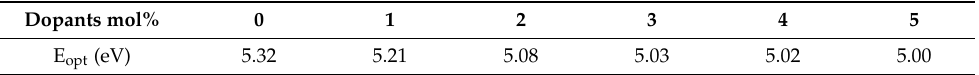
Table 5. Optical band gap for willemite doped with different Ce 3+ concentrations calcined at 900 ◦